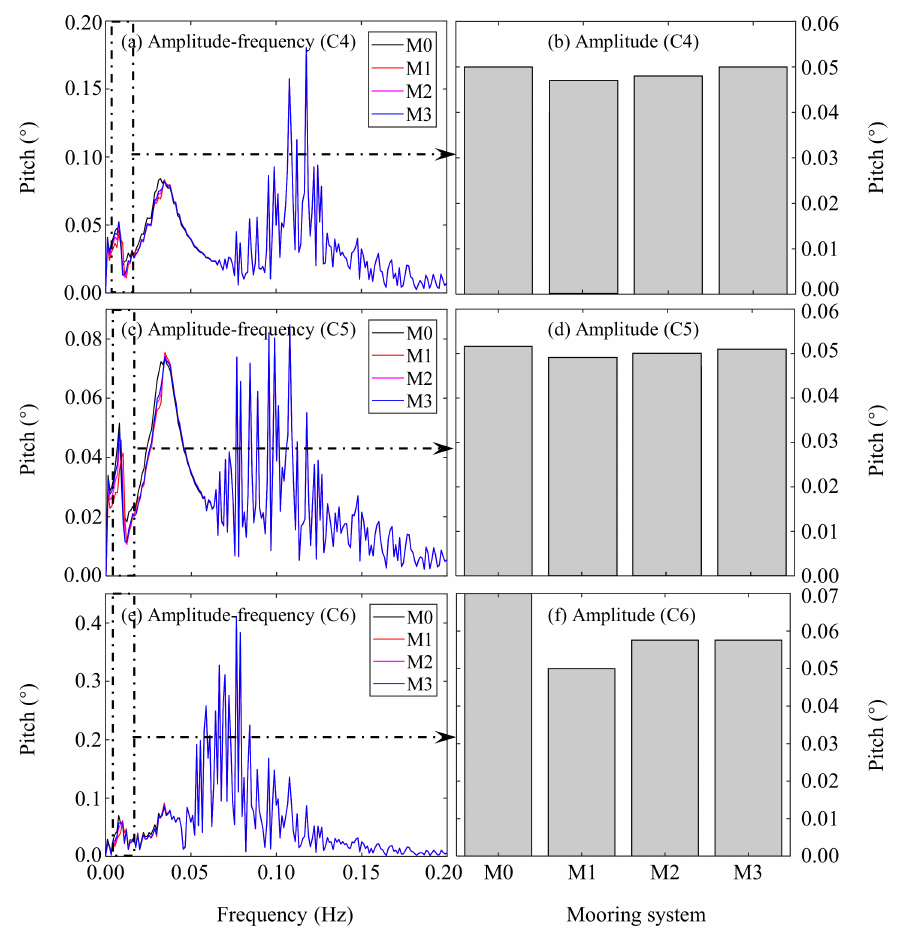
Figure 13. Wind turbine pitch movement in frequency domain with M0–3 when under: ( a ) amplitude- frequency (C4); ( b ) amplitude (C4); ( c ) amplitude-frequency (C5); ( d ) amplitude (C5); ( e ) amplitude- frequency (C6); ( f ) amplitude